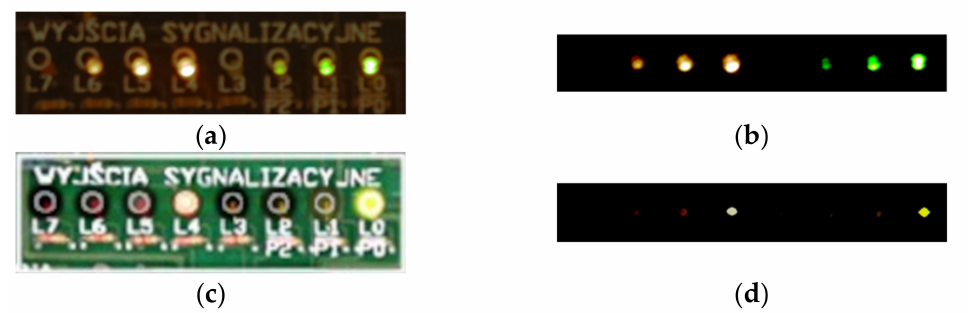
Figure 6. The LED bar of MKD-51 didactic system fed by different PWM duty cycles: ( a ) the real MKD-51 photo; ( b ) the real MKD-51 photo after normalization; ( c ) the MKD-51 SIM image; ( d ) the MKD-51 SIM image after normalization.